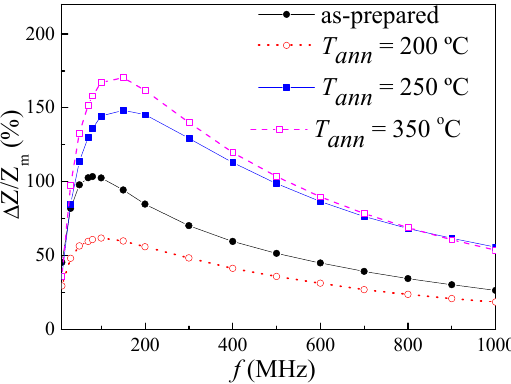
Figure 5. Frequency dependence of the maximum GMI ratio evaluated for as-prepared and annealed at di ff erent T ann microwires.